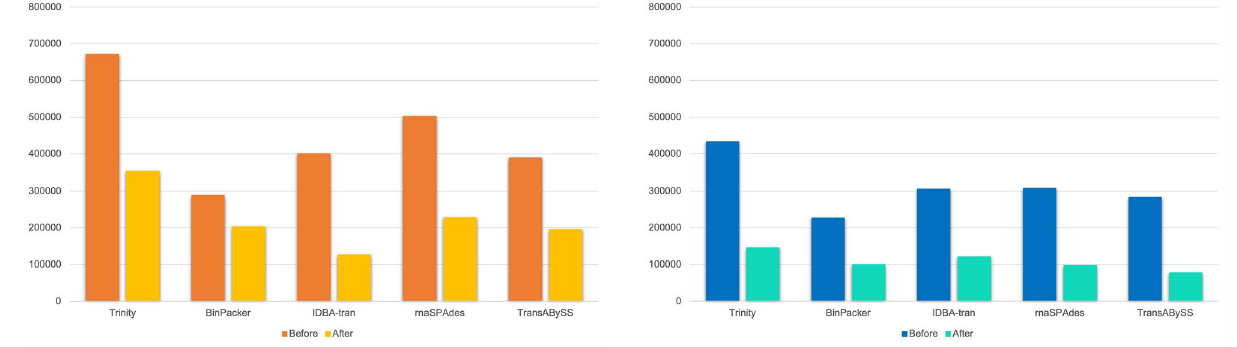
Figure 1. Transcriptome quality assessment results. Results of the first assembly filtering in terms of total number of